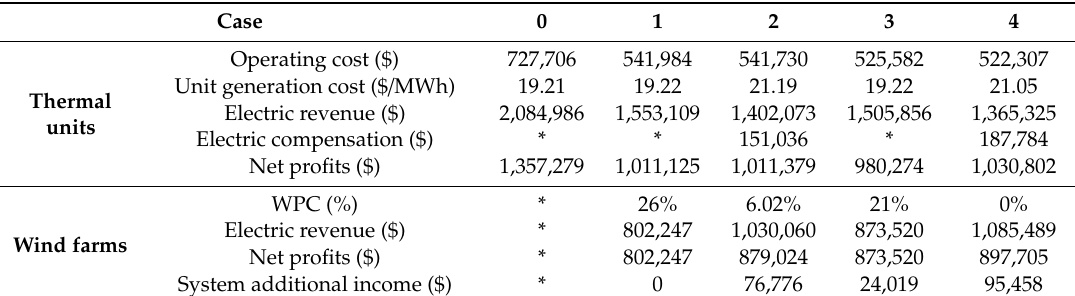
Table 4. The Simulation Results.